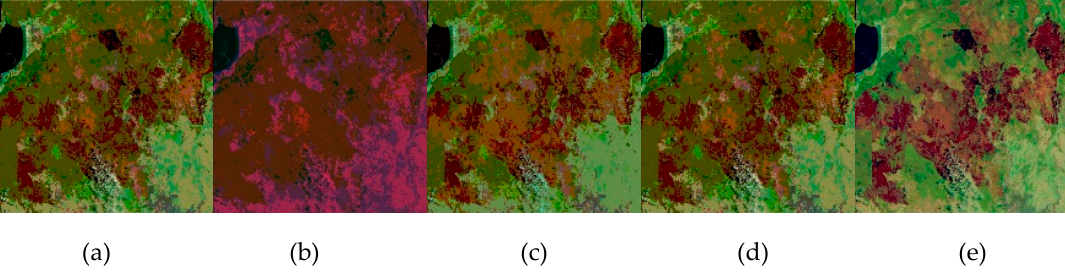
Figure 12. The segmented results of Satellite image5. ( a ) WOA; ( b ) FPA; ( c ) PSO; ( d ) BA; and ( e ) HSOA.